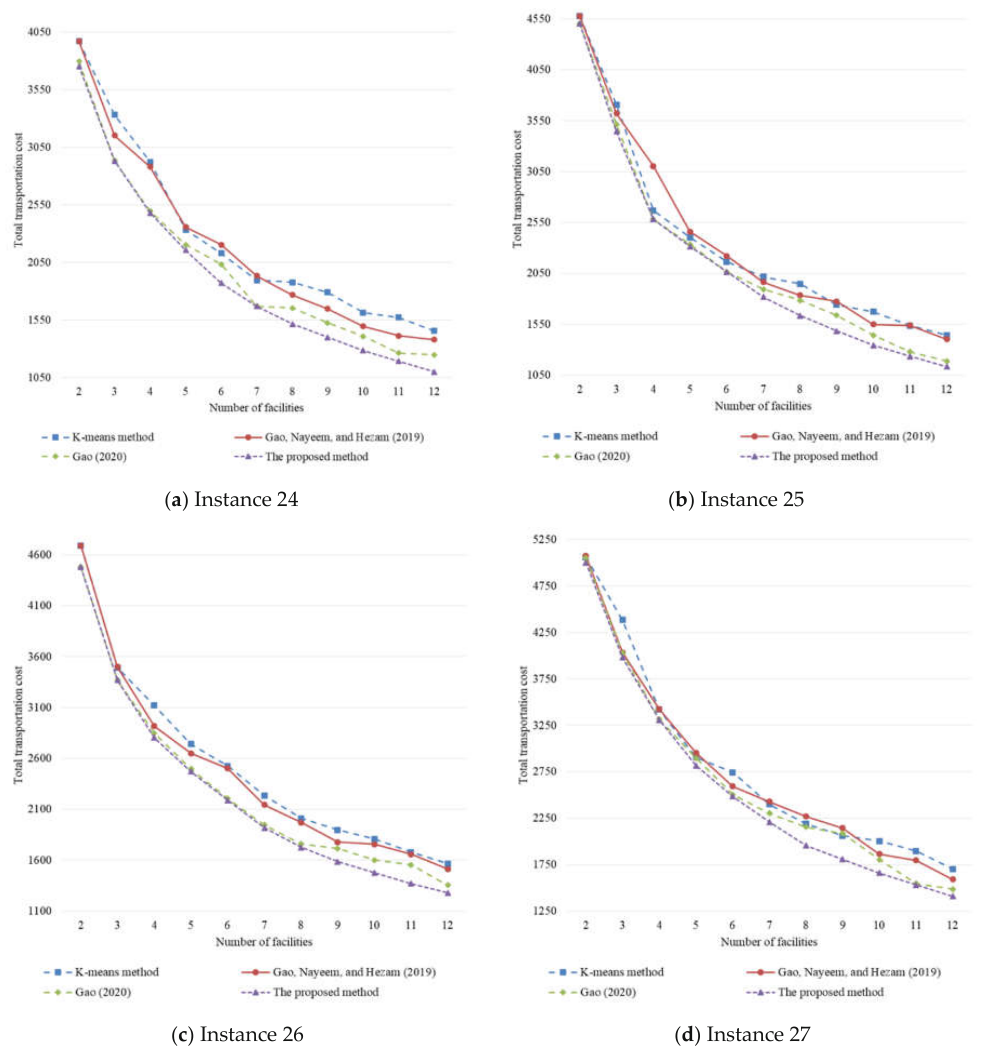
Figure 13. Comparison of transportation costs using different methods for Instances 24–27. ( a ) Instance 24; ( b ) Instance 25; ( c ) Instance 26; ( d ) Instance 27.